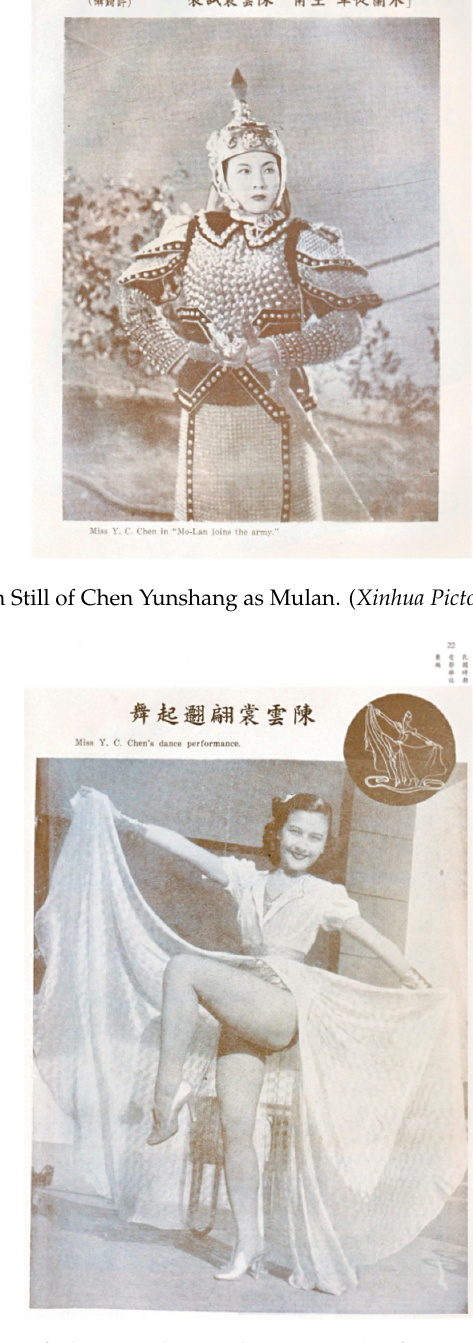
Figure 3. Picture of Chen Yunshang’s dance pose. ( Xinhua Pictorial, no.1, 1939.).